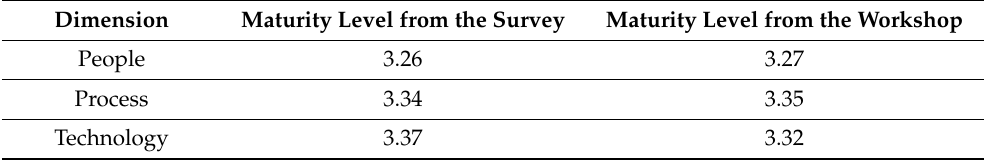
Table 3. Average maturity levels for successful technology implementation from the survey and workshop validation.